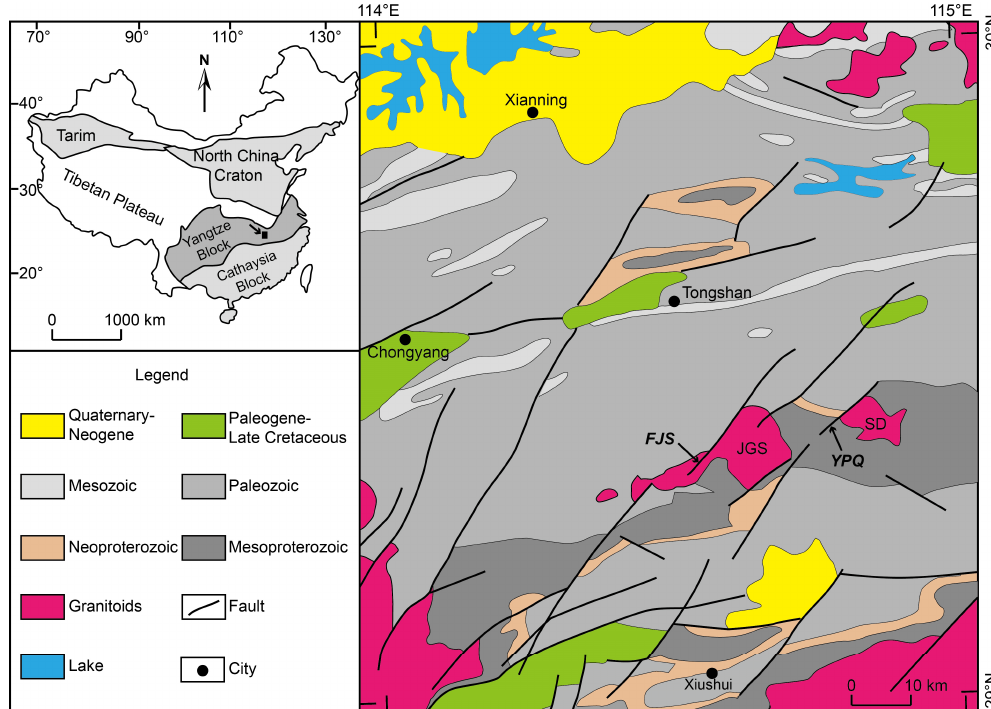
Figure 1. Schematic map of southeastern Hubei Province (China), showing locations of the Jiu- gongshan and Shadian granitic intrusions. Base map is modified from Bureau of Geology and Mineral Resources of Hubei Province [36]. Black arrow in the inset map showing the area of geology map. JGS = Jiugongshan intrusion, SD = Shadian intrusion, FJS = Fujiashan quartz deposits, YPQ = Yipanqiu quartz deposits.